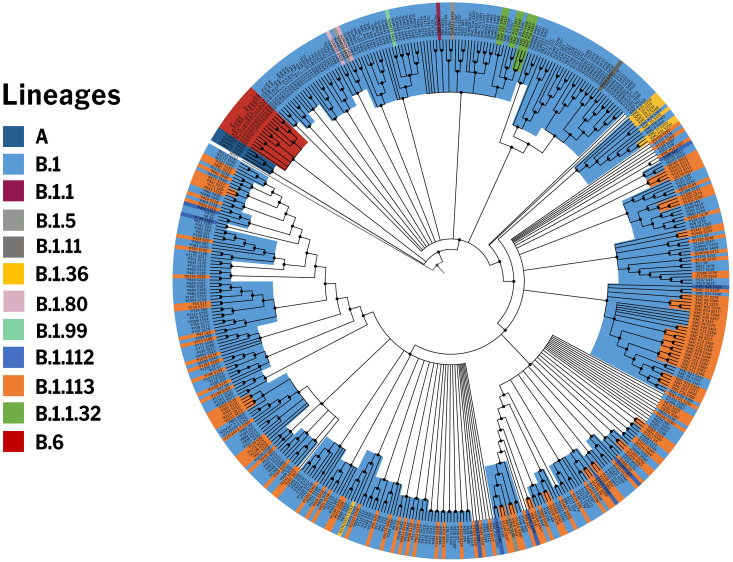
Phylogenetic distribution of PANGOLIN lineages in COVIDseq genomes.The distribution of lineages assigned by PANGOLIN in 469 COVIDseq genomes with the Wuhan/WH01 (EPI_ISL_406798) as reference.